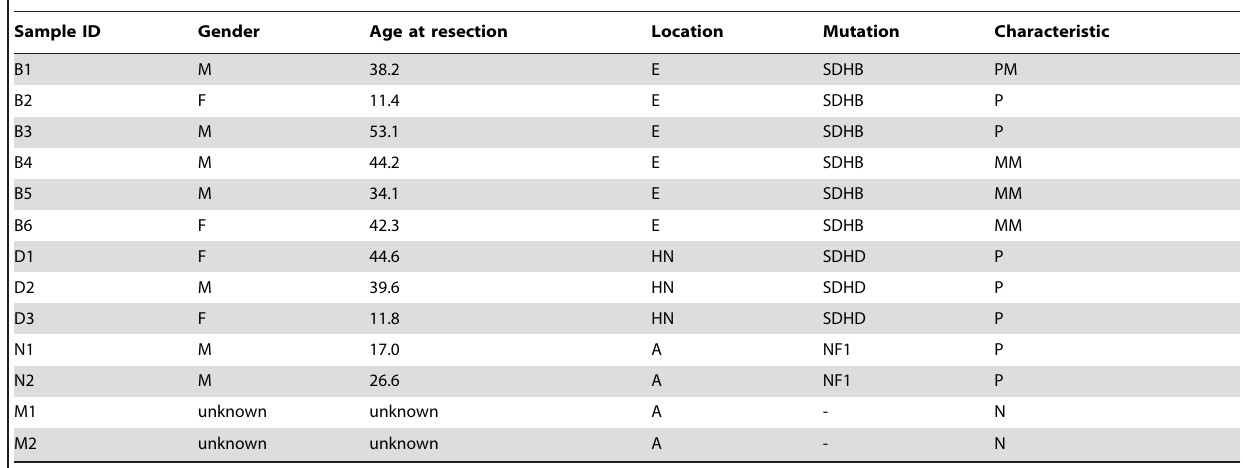
Table 1. Patient information.